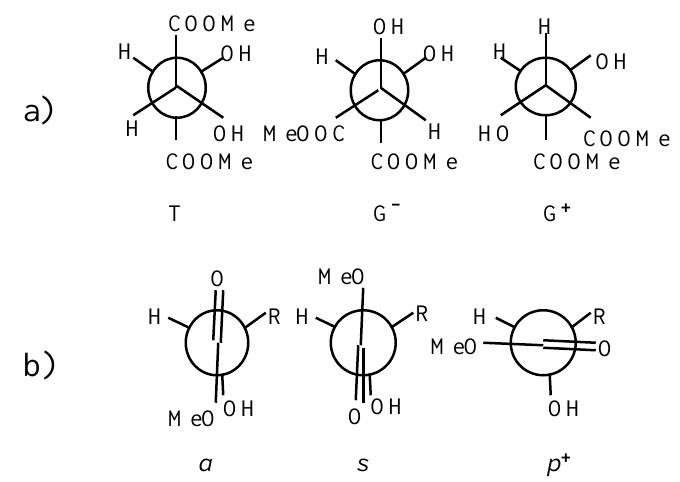
Figure 1. Explanation of notation used to describe conformations of (R,R)-tartaric acid dimethyl diester. a) T ( trans ), G + – – ( gauche + ) and G ( gauche ) conformers describing the rotation about C * -C * bond. b) s ( synplanar ), a ( antiplanar ), p +